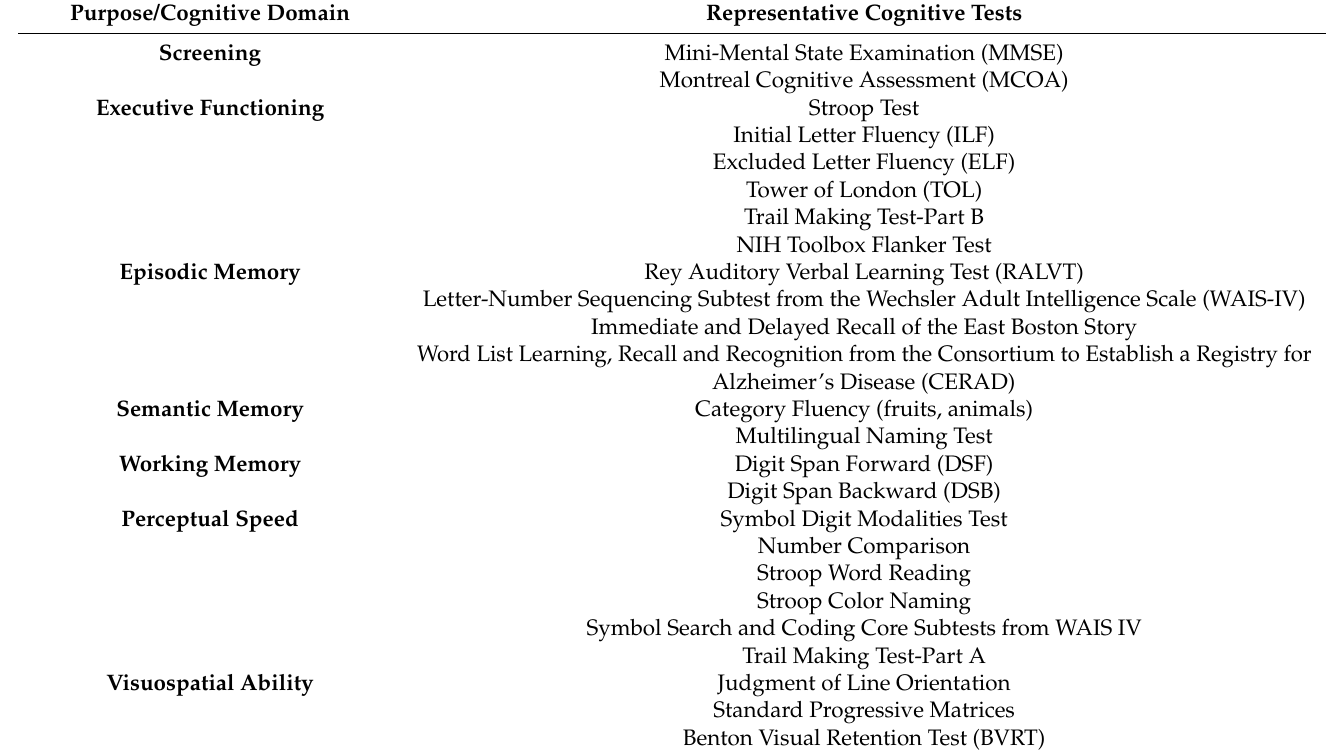
Table 4. Representative examples of tests used in a neuropsychological test battery